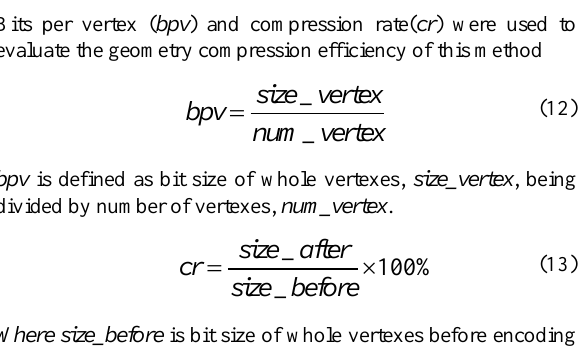
TABLE I . T HE ASSESSMENT OF THE ENCODNG METHOD IN DIFFERENT 3 D GEOGRAPHICAL ENTITIES (The table is attached at the end of the